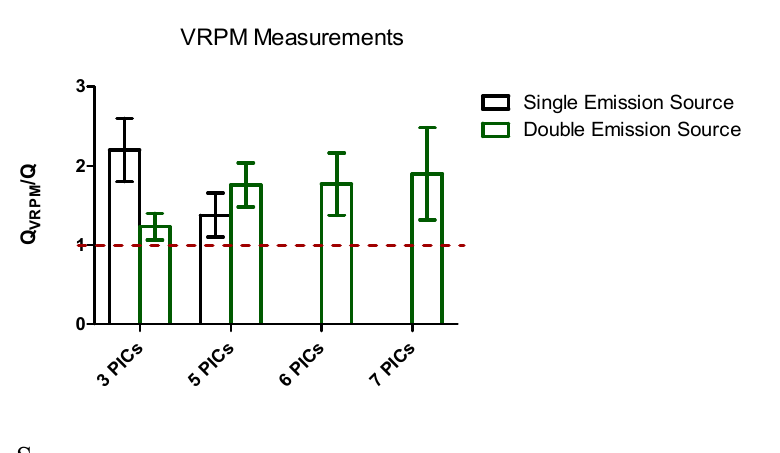
Figure 3. Accuracy of measured emission Q path integrated concentration data